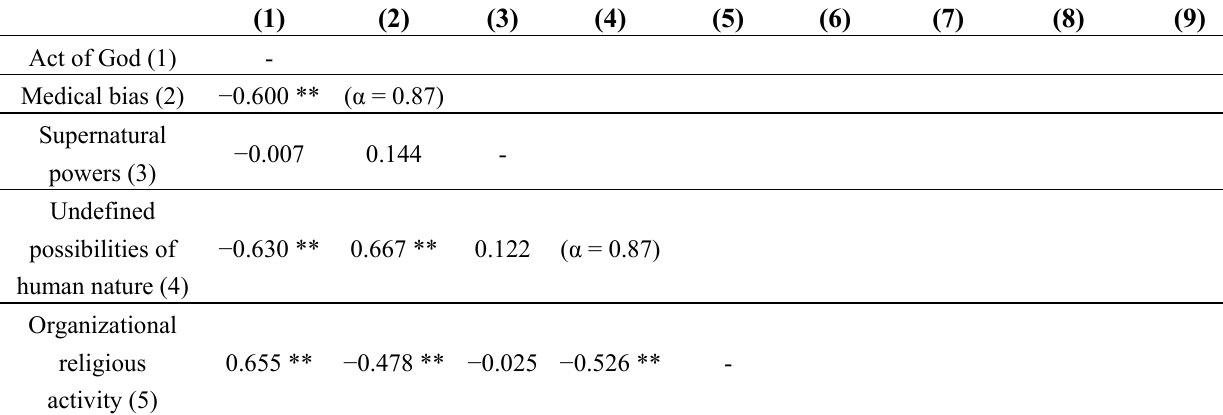
Figure 1. The distribution of results for various beliefs on miraculous healings (On the figure are presented minimum, maximum, median and interquartile range in each dimension). Table 2. The relationship between perception of miraculous healings, religiosity and aspects of the meaning of life (Spearman’s rank correlation